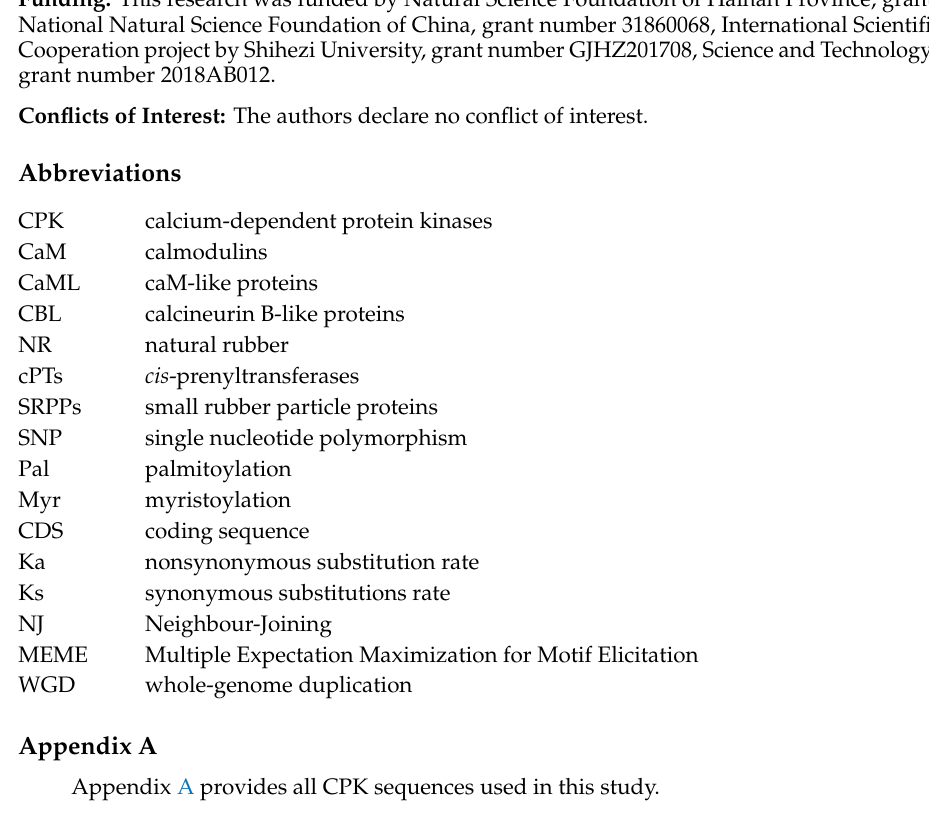
Figure S1: Gene structure and conserved motif distribution of CPKs from group I., Figure S2: Gene structure and conserved motif distribution of CPKs from group II., Figure S3: Gene structure and conserved motif distribution of CPKs from group IV., Table S1: The Ka / Ks ratios for duplicated CPK genes in T. koksaghyz , Table S2: The Ka / Ks ratios for duplicated CPK genes in H. annuus , Table S3: The Ka / Ks ratios for duplicated CPK genes in L. sativa , Table S4: The Ka / Ks ratios for duplicated CPK genes in C. cardunculus , Table S5: The Ka / Ks ratios for duplicated CPK genes in C. nankingense , Table S6: Tajima relative rate tests of CPK gene pairs in H. annuus , Table S7: Tajima relative rate tests of CPK gene pairs in L. sativa , Table S8: Tajima relative rate tests of CPK gene pairs in C. cardunculus , Table S9: Tajima relative rate tests of CPK gene pairs in C. nankingense